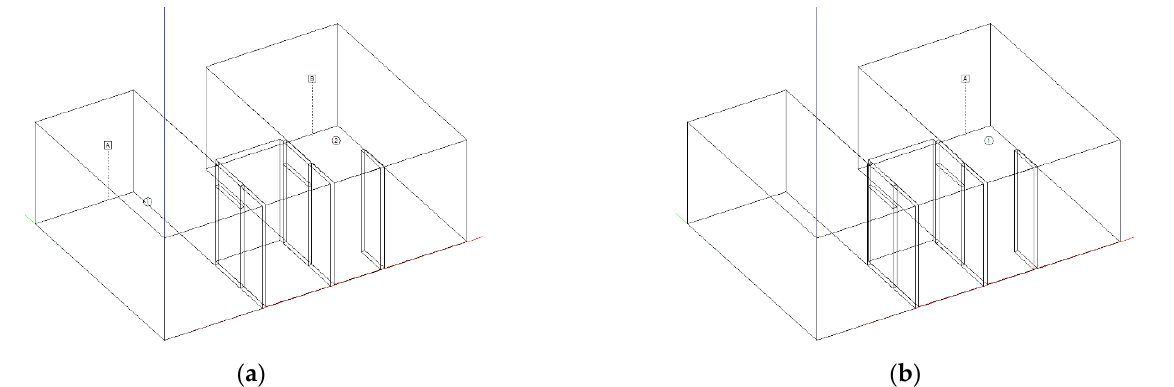
Figure 13. Two-room apartment. Day configuration: ( a ) all CVM on, ( b ) only living room/kitchen CVM on.